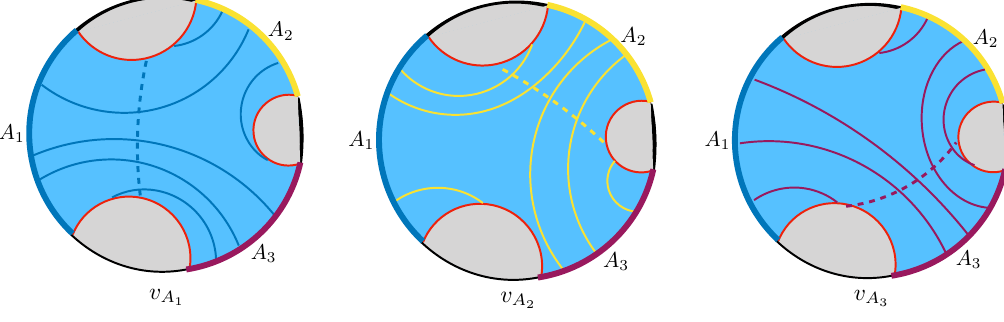
to (3.11) for three regions. Note the V